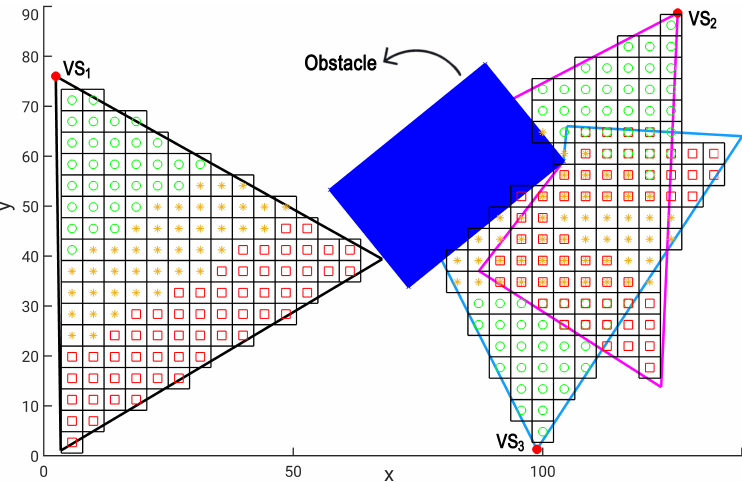
Figure 4. Quality of the performed area coverage when viewing monitoring